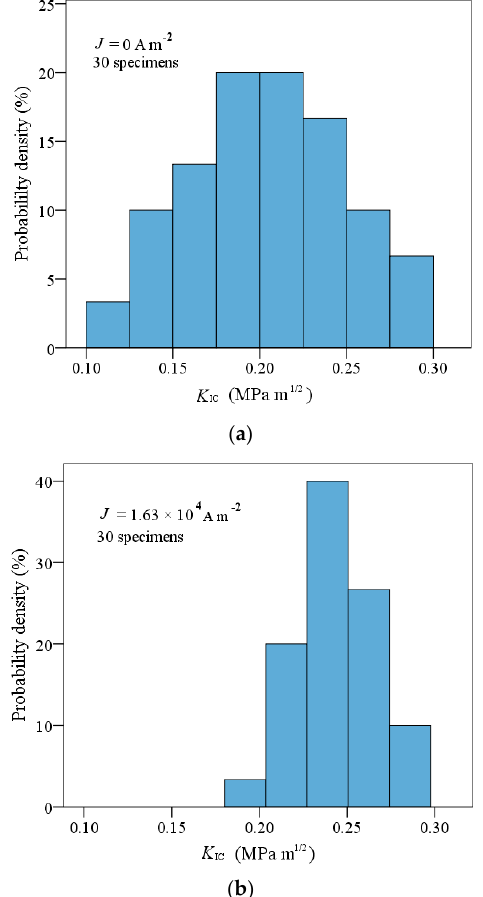
Figure 9. The probability density of K IC under ( a ) the pure mechanical loading and ( b ) the combined electrical and mechanical loading (1.63 × 10 4 A m − 2 ).